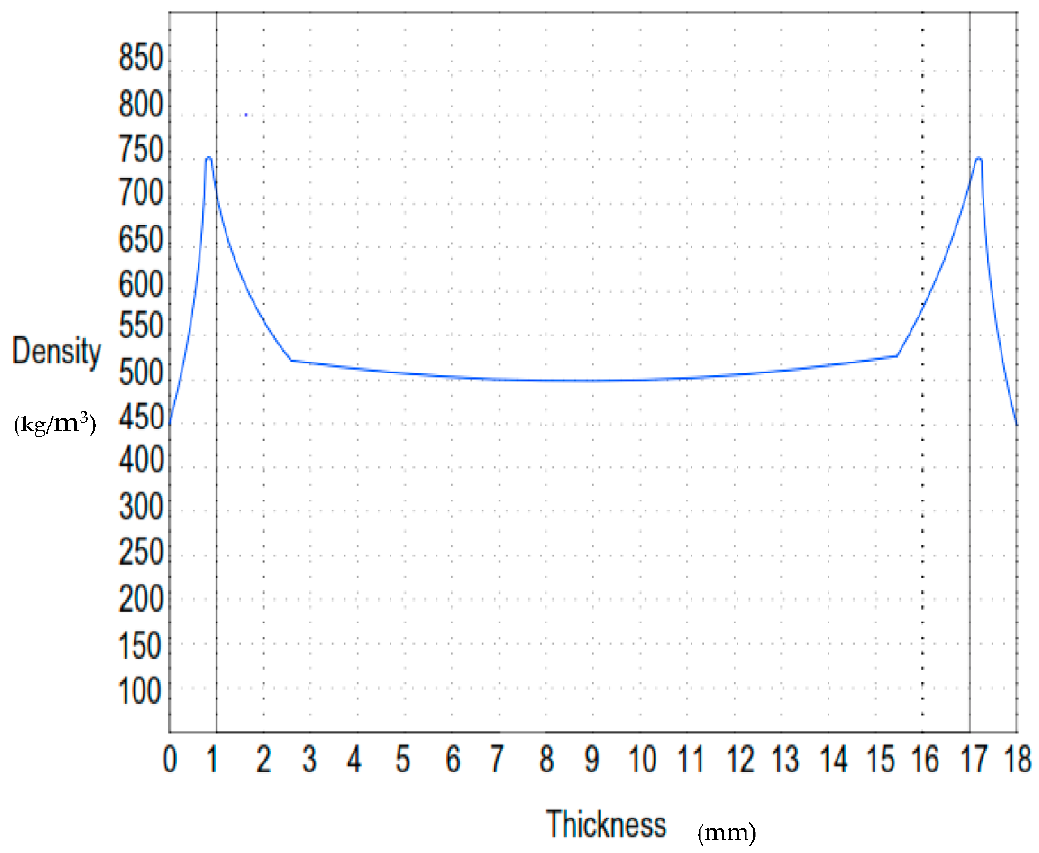
Figure 10. X-ray vertical density profile of 3 rd specimen. Table 12. Density profile across Table 15. Experimental data of 3 rd sample.